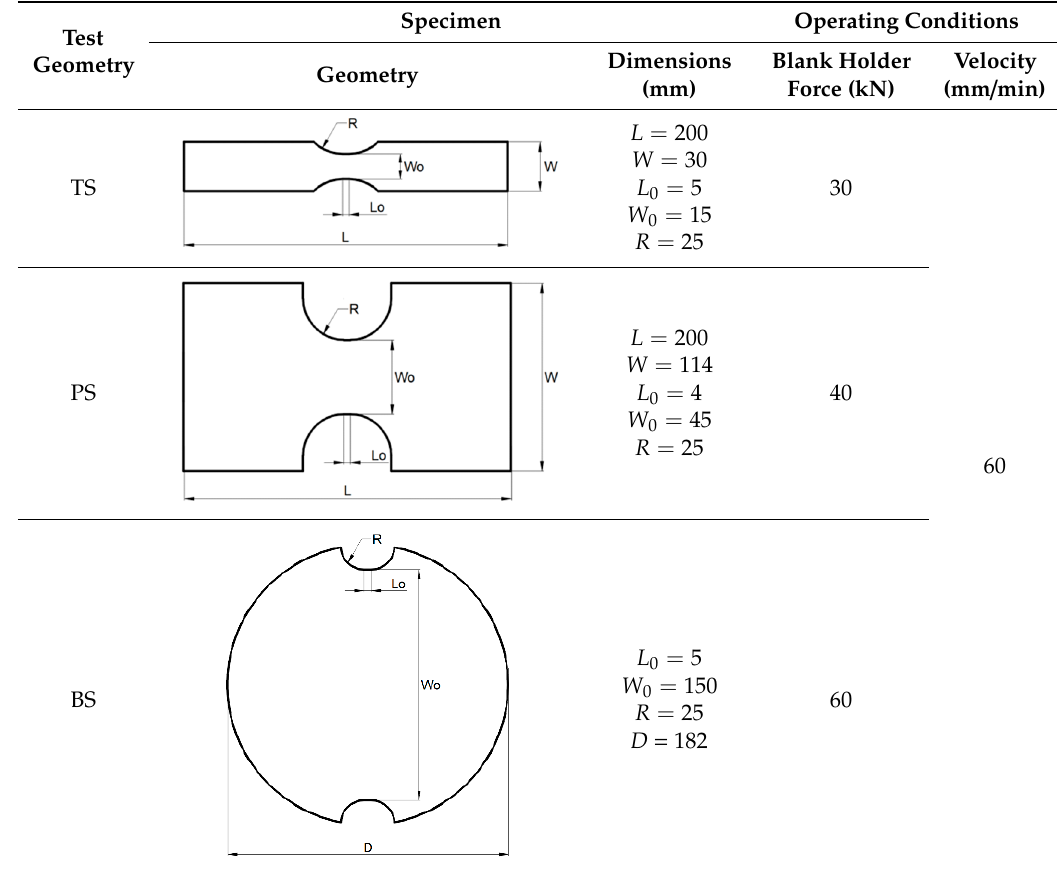
Table 1. Summary of the experimental work plan for PC specimens.